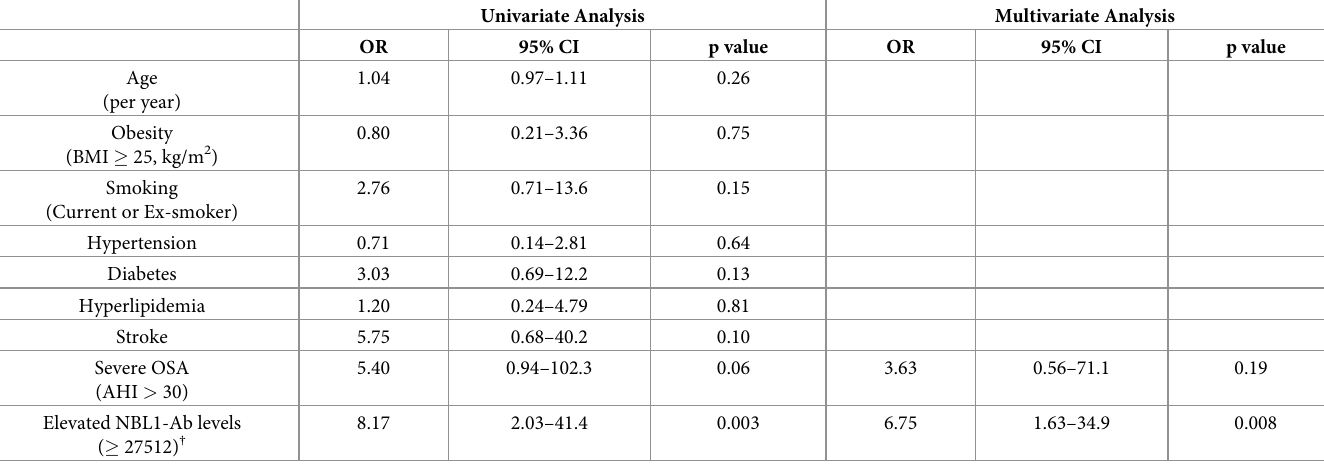
Table 2. Logistic regression of the prevalence of CAD in patients with OSA (n = 82; no. of events =